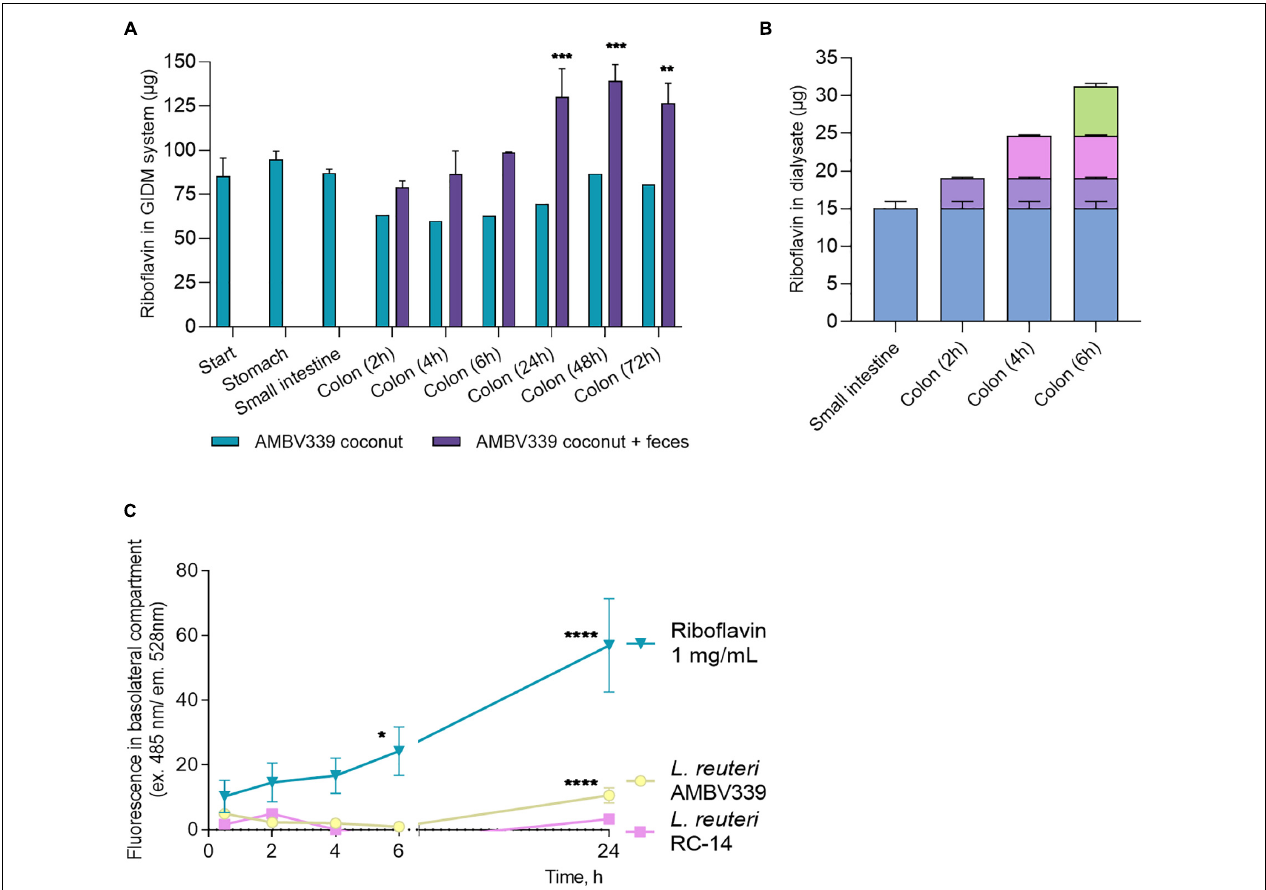
FIGURE 5 | (A) Total amount of riboflavin in the different parts of the GIDM-colon system after addition of L. reuteri AMBV339 culture in coconut beverage without (“AMBV339 coconut”) or with the human fecal microbiome (“AMBV339 coconut + feces”); Data is presented as means ± SD. ** p < 0.01, *** p < 0.001 compared to the riboflavin levels measured at the start of the GIDM system. (B) Riboflavin transfer into dialysate by passive diffusion from the small intestine and colon stages of the GIDM-colon system (measured up to 6h in this experimental set-up). (C) Active transport of riboflavin produced by L. reuteri AMBV339 through intestinal epithelial Caco-2 monolayers. Pure riboflavin as such was used for comparison (riboflavin 1 mg/ml condition). Data is presented as means ± SD per time point. * p < 0.05, ** p < 0.01, *** p < 0.001, **** p < 0.0001 compared to the MRS medium